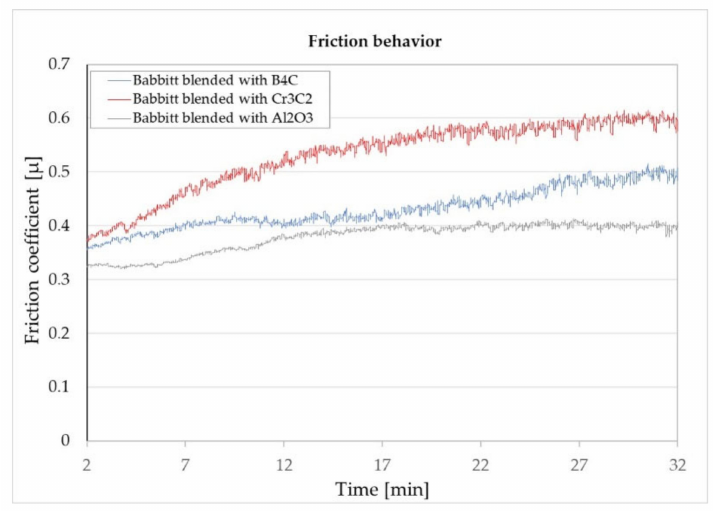
Figure 10. The coe ffi cient of friction of the di ff erent Sn-based Babbitt